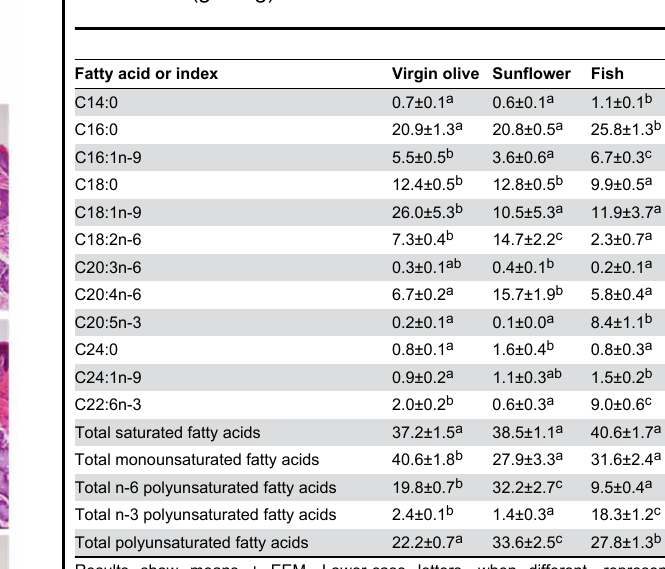
Table 4. Plasma fatty acids in rats fed on different dietary fat sources (g/100g).